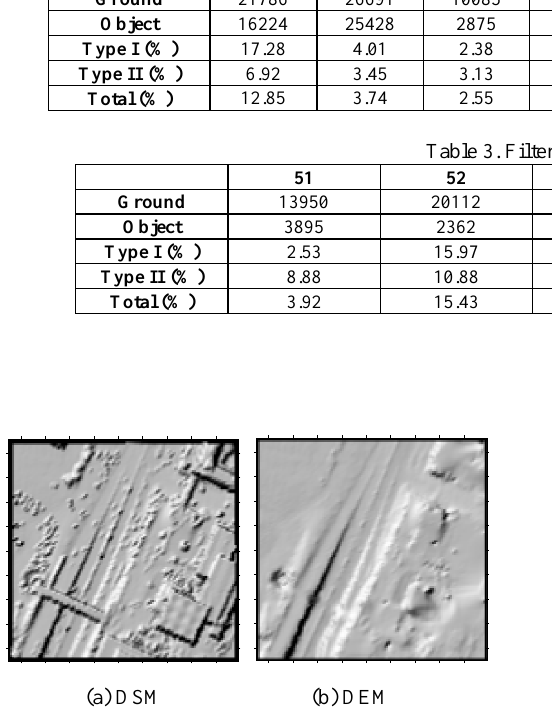
Figure 2. Filtering result of sample 22